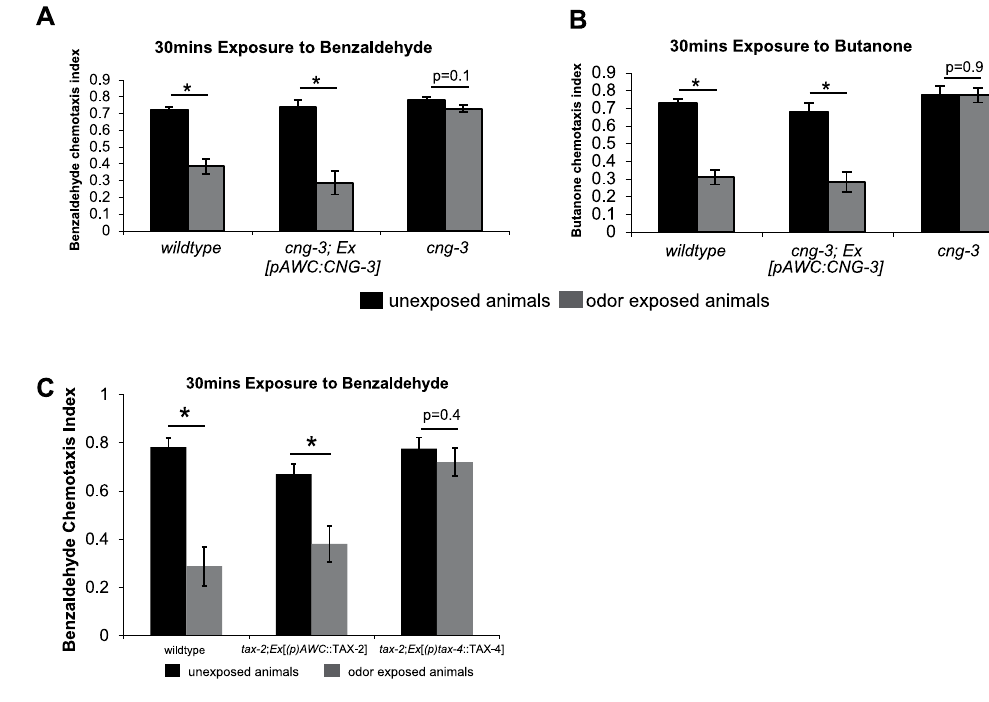
Figure 2. CNG-3 functions in AWC for short-term adaptation responses, and tax-2 − / − mutants that overexpress TAX-4 are defective for short term adaptation to AWC-sensed odors. ( A ) Chemotaxis assays were performed on wildtype animals, cng-3(jh113) that express the cDNA encoding CNG-3 under an AWC specific promoter [ (p)AWC ::CNG-3], and also cng-3(jh113) mutant animals. Wildtype animals and cng-3(jh113) mutant animals expressing the extrachromosomal array Ex [ (p)AWC ::CNG-3] both exhibited significant differences in the chemotaxis index after 30 min odor exposure as compared with non-exposed animals (paired t-test, * p < 0.05). Whereas cng-3(jh113) mutant animals exhibited no significant change in the chemotaxis index when comparing exposed animals to that of non-exposed animals (paired t-test, p = 0.1). ( B ) Chemotaxis assays were performed on wildtype animals, cng-3(jh113) ; Ex [ (p)AWC ::CNG-3] animals and cng-3(jh113) mutant animals to the AWC sensed odor butanone. Wildtype animals and cng-3(jh113) ; Ex [ (p)AWC ::CNG-3] animals both exhibited significant differences in the chemotaxis index after 30 min odor exposure as compared with non- exposed animals (paired t-test, * p < 0.05), and cng-3(jh113) mutant animals exhibited no significant difference in chemotaxis index between exposed and non-exposed animals (paired t-test, p = 0.9). ( C ) Wildtype animals and also tax-2(p691) ; Ex [ (p)AWC ::TAX-2 OE] transgenic animals exhibit significant differences in chemotaxis after 30 mins odor exposure as compared with unexposed controls (paired t-test, * p < 0.05). The tax-2(p691) ; Ex [ (p)tax-4 ::TAX-4 OE] animals can detect benzaldehyde similar to wildtype animals but fail to adapt to the odor after 30 mins of odor exposure (paired t-test, p = 0.4). For ( A–C ) Black bars indicate unexposed animals and gray bars indicate odor exposed animals. All assays were repeated 5 times on separate days. For all graphs, error bars represent